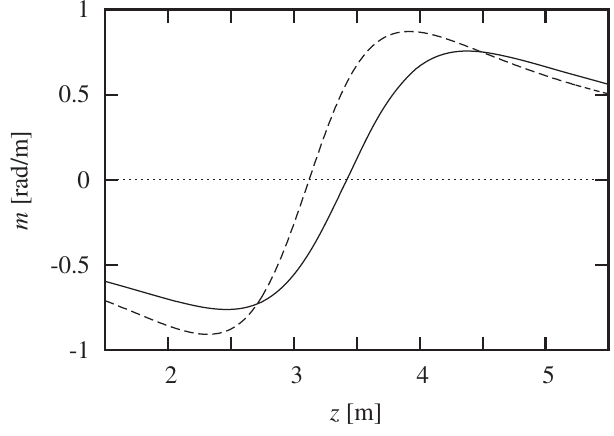
FIG. 13. Transverse beam size (green line) and aspect ratio (red line) in the injector. The maximum beam size occurs inside the solenoid at 0.4 m, and a second, local maximum occurs at the entrance of the cavity section at ∼ 4 m. The beam size minimum at 3.3 m is close to the local emittance maximum. The effect of overfocused particles onto the beam size is negligible.